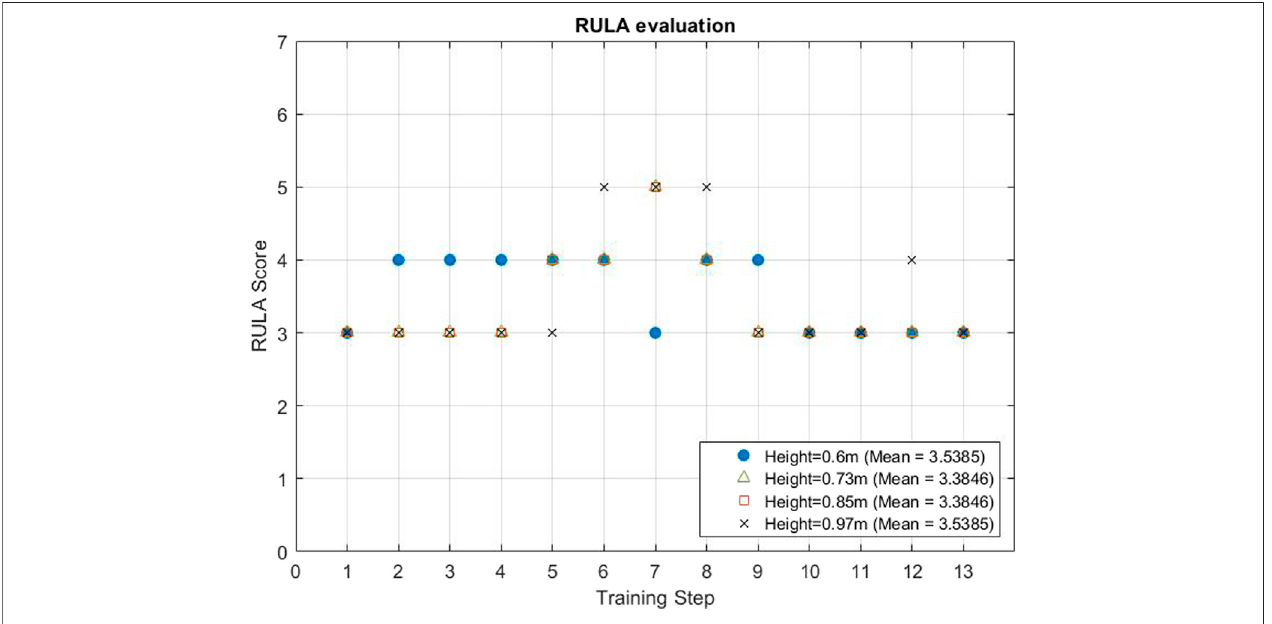
FIGURE 10 | RULA scores for different table heights for a given human model.